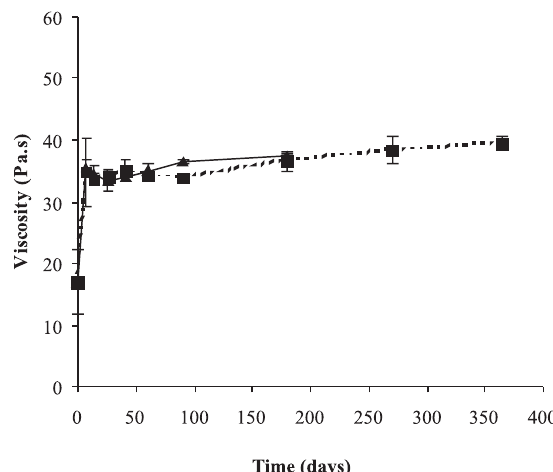
FIGURE 1 - Viscosity values in lots stored at room temperature (■) and oven (▲), (mean ± SD, n = 3).